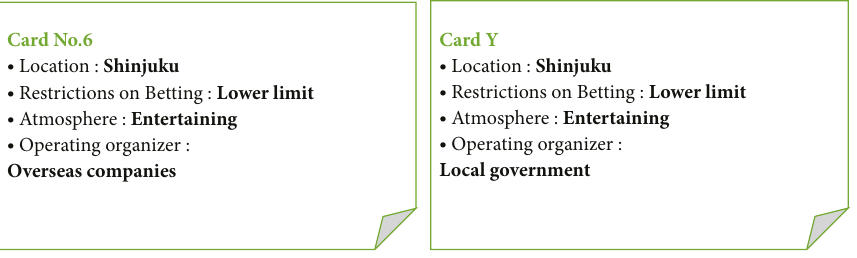
Figure 8: A comparison between two cards with low rating scores.